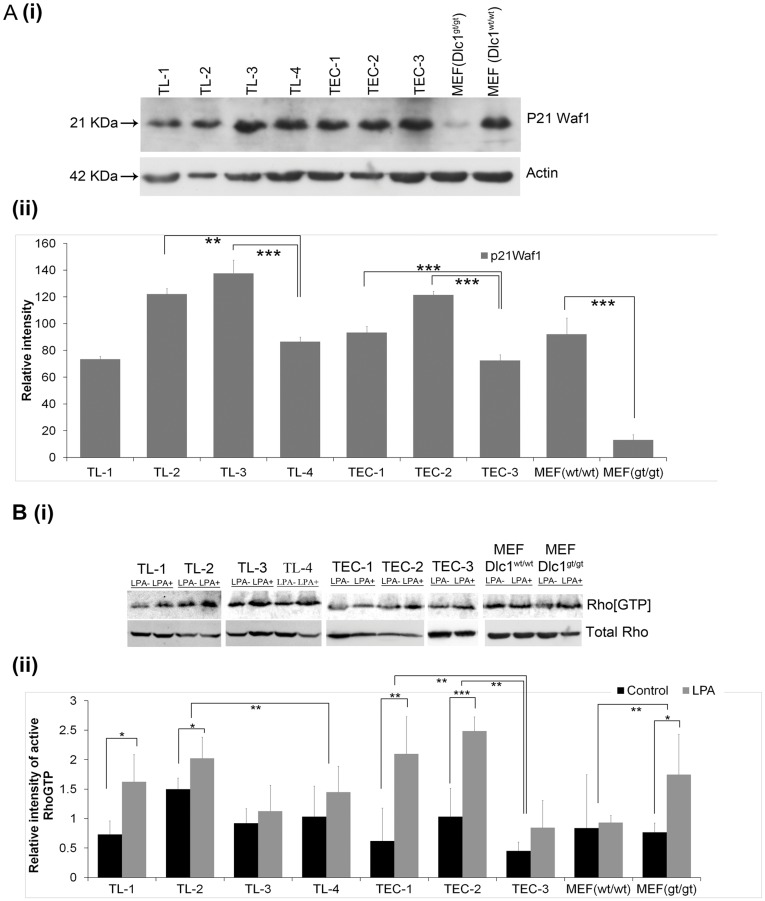
Western blots showing p21waf1 expression and active Rho in TEC and TL cell lines.A(i) p21waf1 protein in T-cell lymphoma and carcinoma cell lines, (ii) Plot showing the relative intensity of p21waf1 protein in T-cell lymphoma and carcinoma cell lines relative to actin. Means and standard error of mean were determined from at least five independent experiments. (*p<0.05, **P<0.01, ***P<0.001, ****P<.0001). (B) Measurement of active RhoGTP in cell lines. (i) RhoGTP pull down assay showing constitutive and LPA induced levels of active RhoGTP in T-cell lymphoma and thymic epithelial carcinoma cell lines. (ii) Plot showing the RhoGTP to total Rho protein ratio by scanning the relative intensity of the protein bands in non-treated and LPA induced in TEC, TL, MEF cell lines. Means and standard error of mean determined from four independent experiments. (*p<0.05, **P<0.01, ***P<0.001 and ****P<.0001 by Student t test and two way ANOVA test.